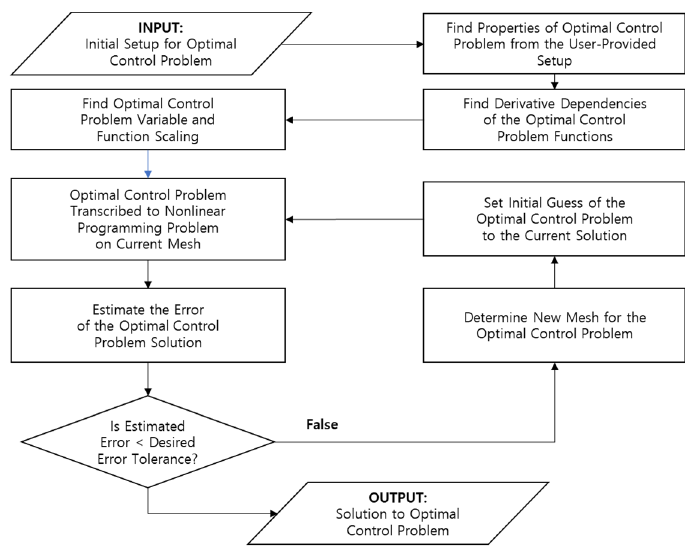
Figure 11. GPOPS-II optimization algorithmic flow.